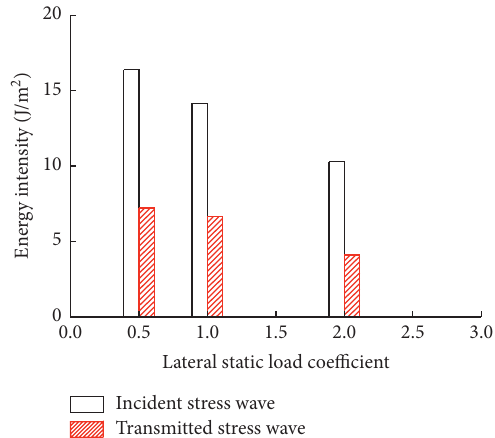
Figure 10: Energy transmitting coefficients of blasting tress wave in intact rock under different equal biaxial static loads.